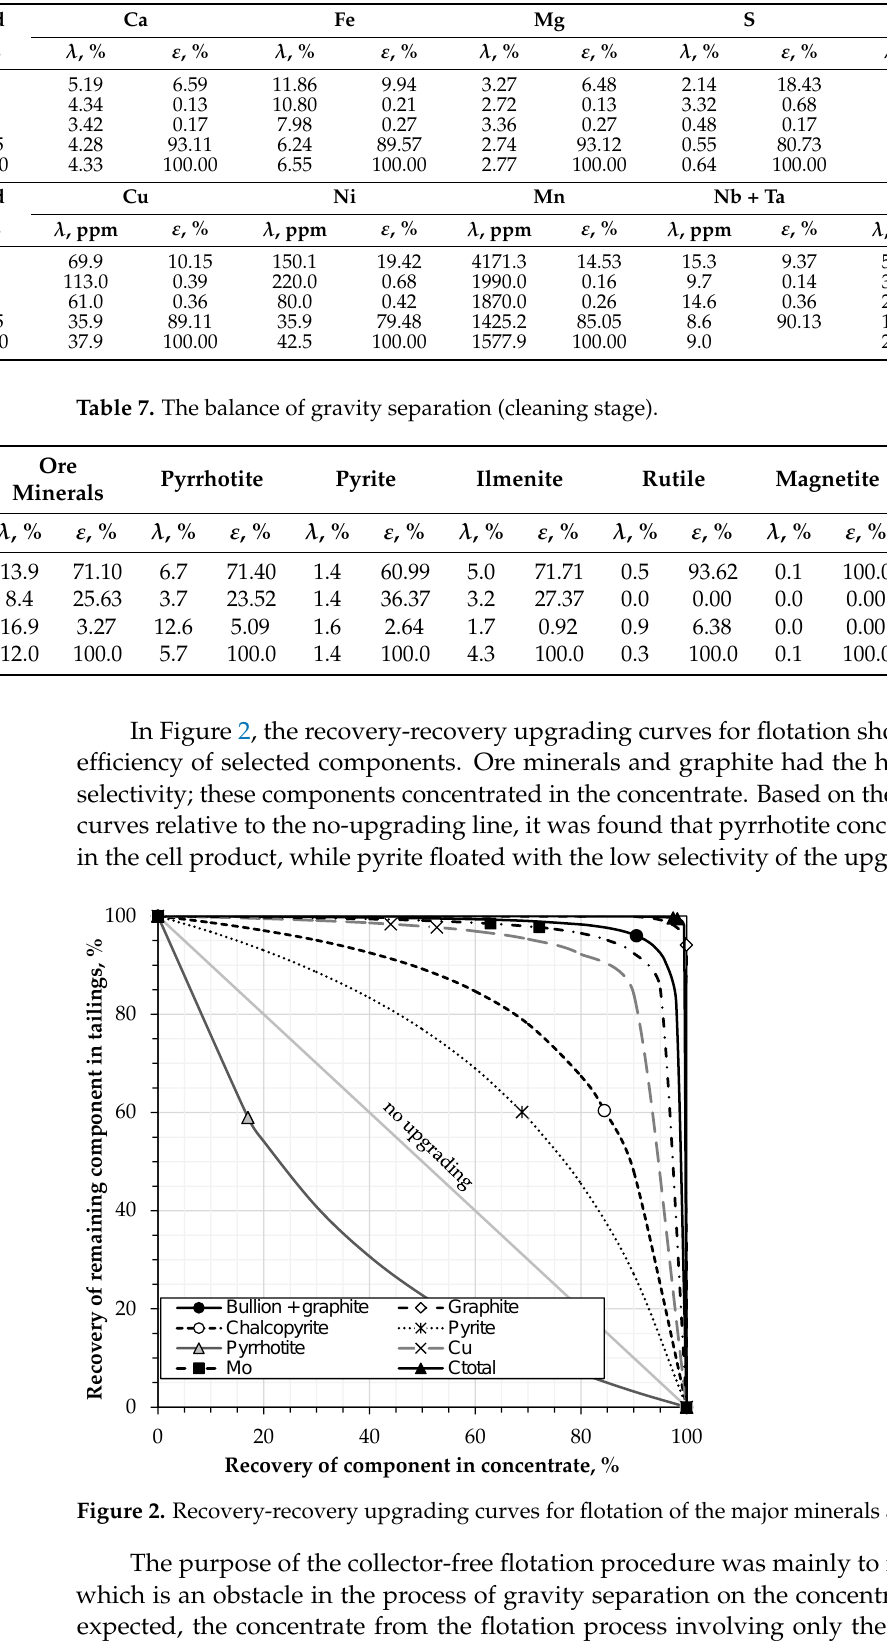
Table 6. The balance of gravity separation.